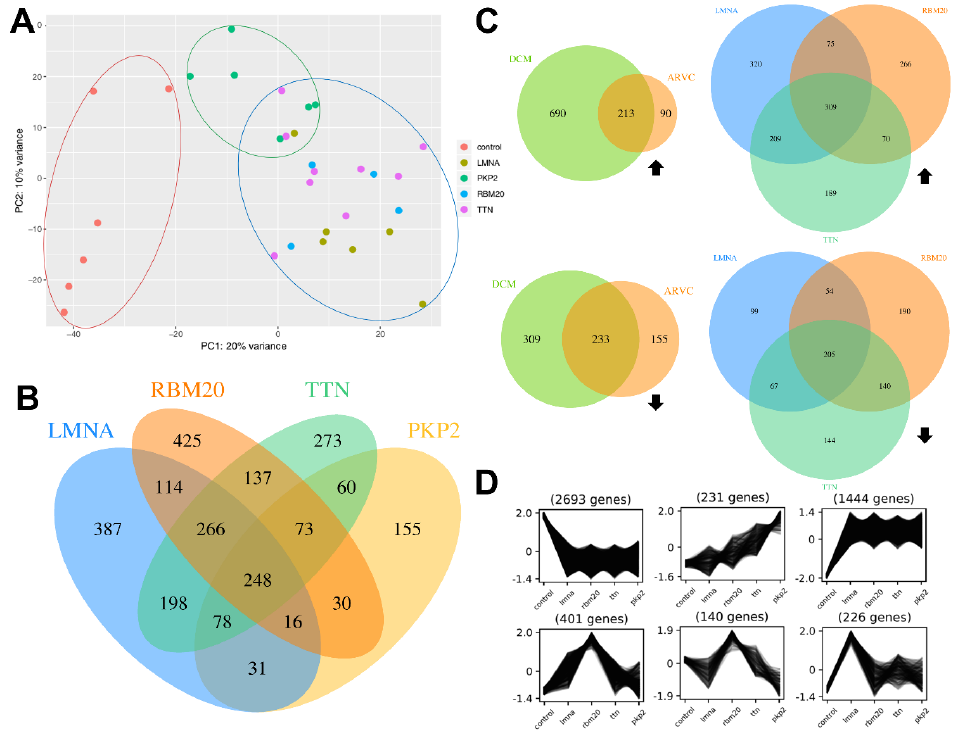
Figure 1. Data overview. ( A ) Principal component analysis (PCA) of all samples. The di ff erent classes (I) control, (II) dilated cardiomyopathy (DCM) and (III) arrhythmogenic right ventricular cardiomyopathy (ARVC) are marked with red, blue and green circles, respectively. ( B ) Venn